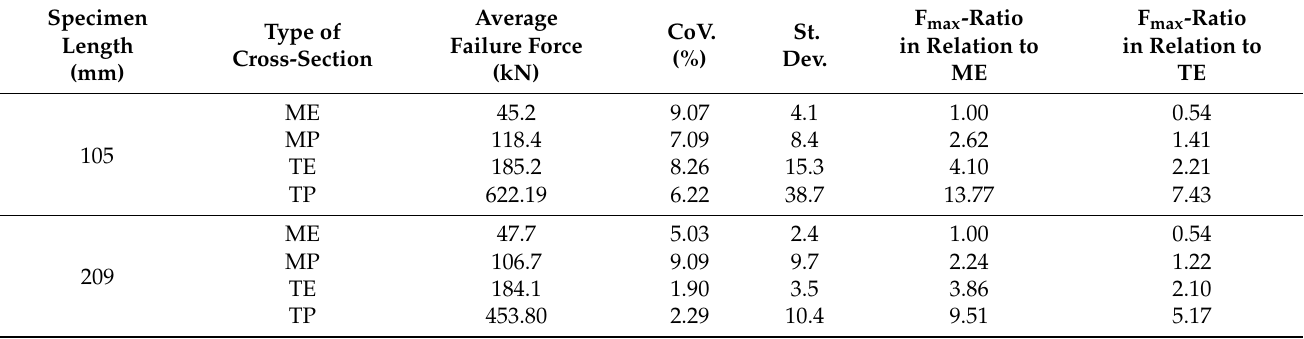
Table 4. Failure